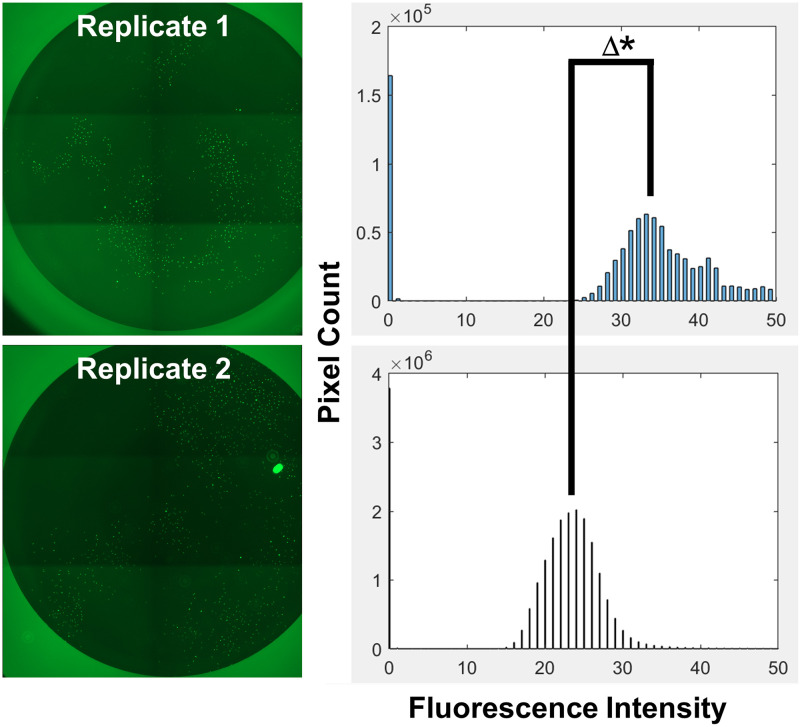
Luminosity variance of EVOS autoexposure.On left, two replicate wells captured using EVOS’ autoexposure setting. On right, Matlab histogram analysis of pixel count and fluorescence intensity of these two replicates. Δ symbol emphasizes difference in mean fluorescence intensities between replicates (introduced by the automatic exposure setting). * p<0.0001 (t-test of random background fields (free of cells), n = 18 fields for each replicate).